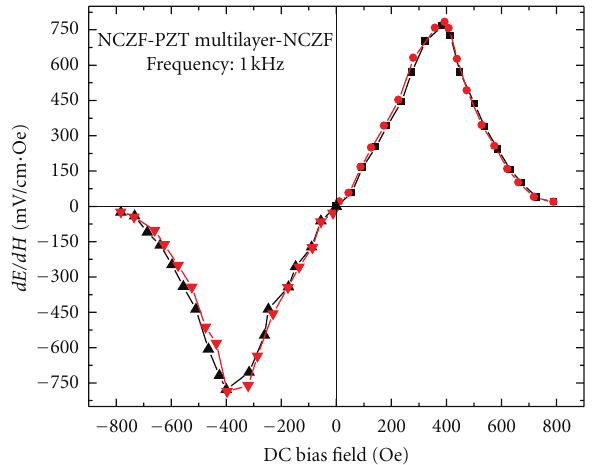
Figure 21: Magnetoelectric coe ffi cient of multilayer [0.9 PZT-0.1 PZN] based trilayer composite.